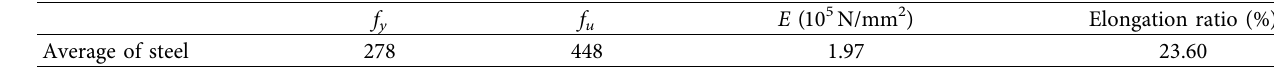
Figure 2: Details of the joints (mm). (a) SJA/B-1. (b) SJA/B-2. (c) SJA/B-3. Note . Angle 1 is the connection/web angle steel; angle 2 is the gusset angle steel; angle 3 is the seat angle steel. Table 2: Properties of steel